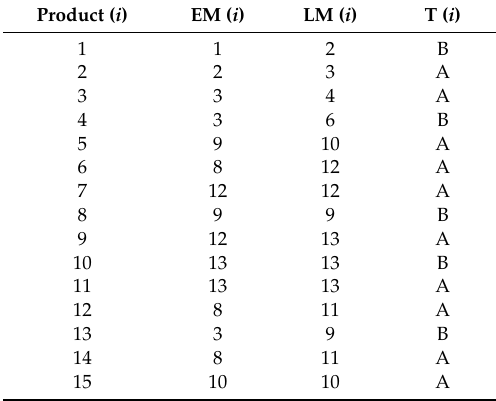
Table 5. Data for operated batches.